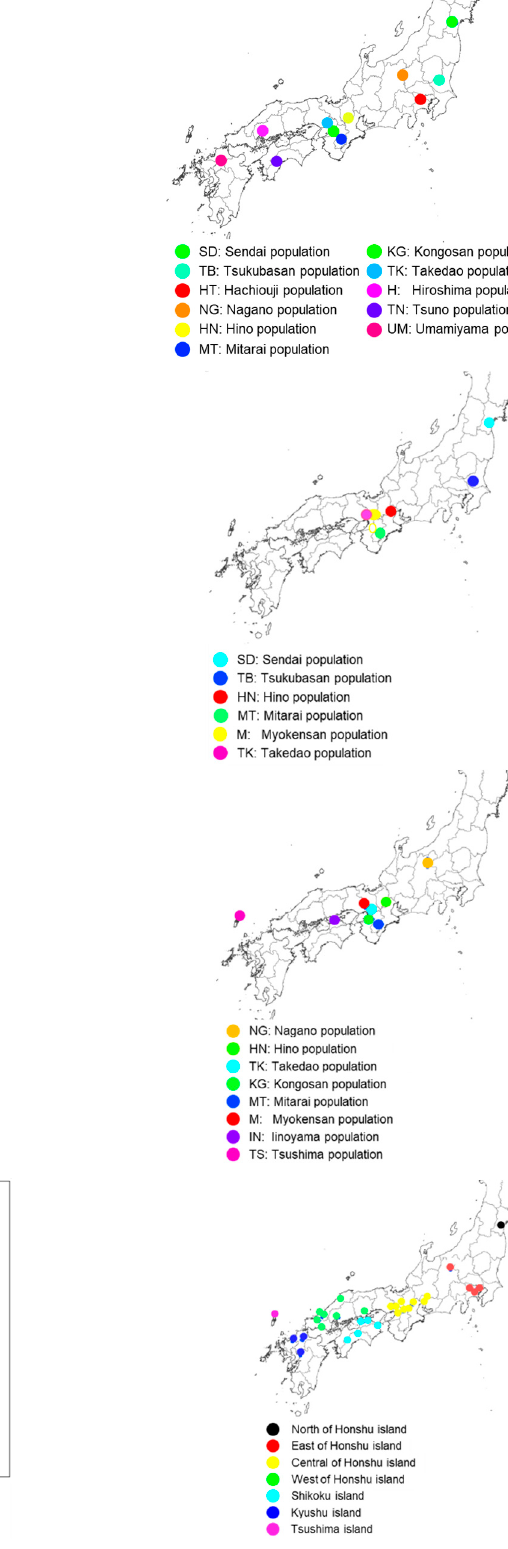
Figure 3. Principal coordinate analysis (PCoA) plot of ( a ) 45 individuals of L. praecox , ( b ) 27 individuals of L. umbellata , ( c ) 39 individuals of L. obtusiloba, and ( d ) 105 individuals of L. glauca . Percentages of total variation explained by each coordinate are shown in parentheses. The marks on the map indicate the location of each population.